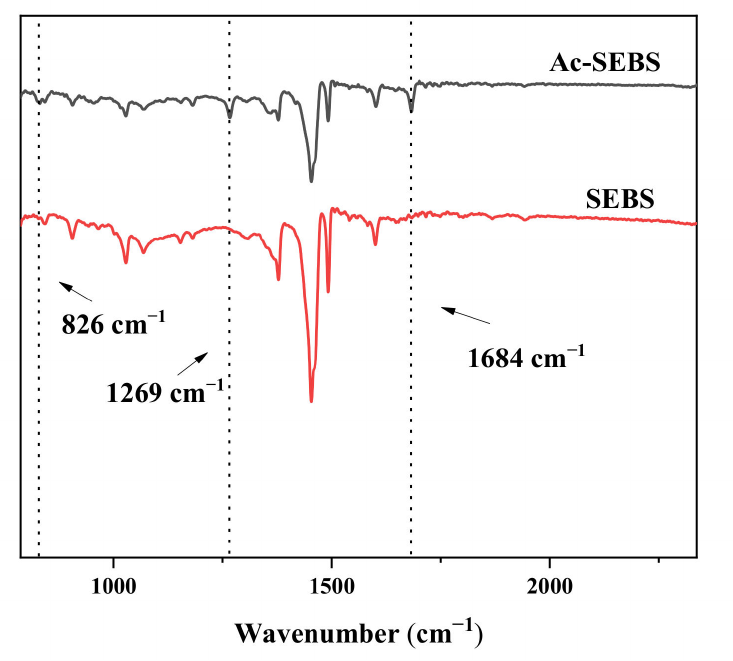
Figure 2. Infrared spectra of SEBS and